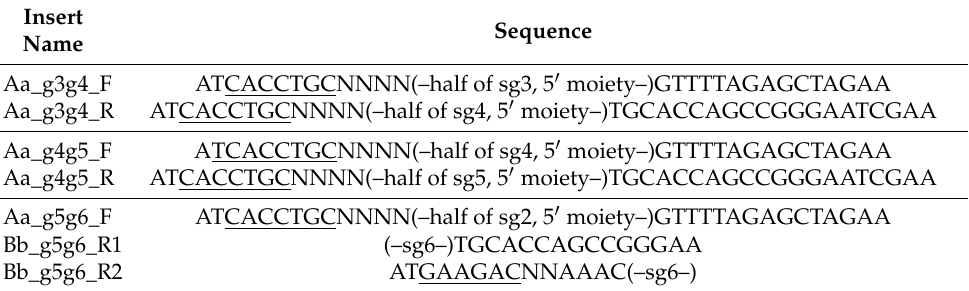
Table 3. List of primers and sequences for the pBAtC_6sg insert.